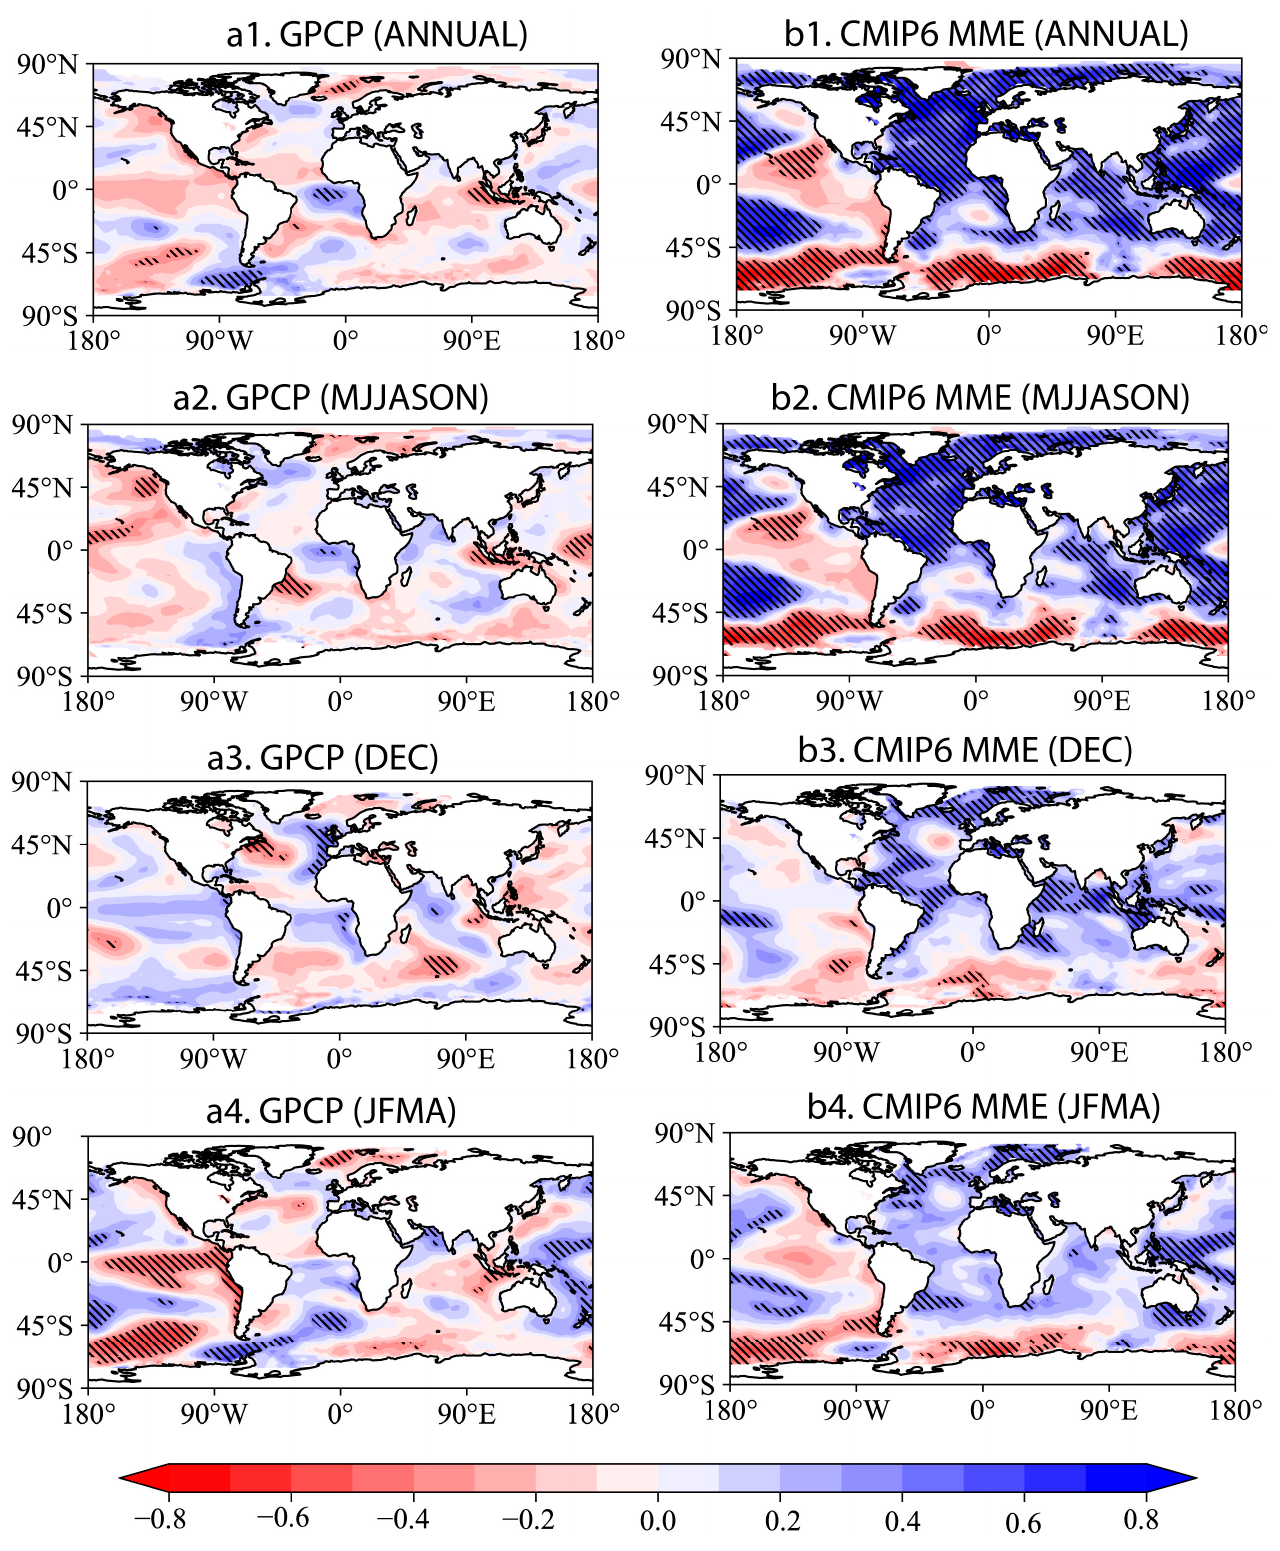
Figure 9. Correlation coefficient between observation GPCP and GCMs and the corresponding sea-surface temperature (SST) at annual scale ( a1 , b1 ), MJJASON ( a2 , b2 ), December ( a3 , b3 ), and JFMA ( a4 , b4 ). from 1980 to 2014. Hatched area indicates a 95% con fi dence level.